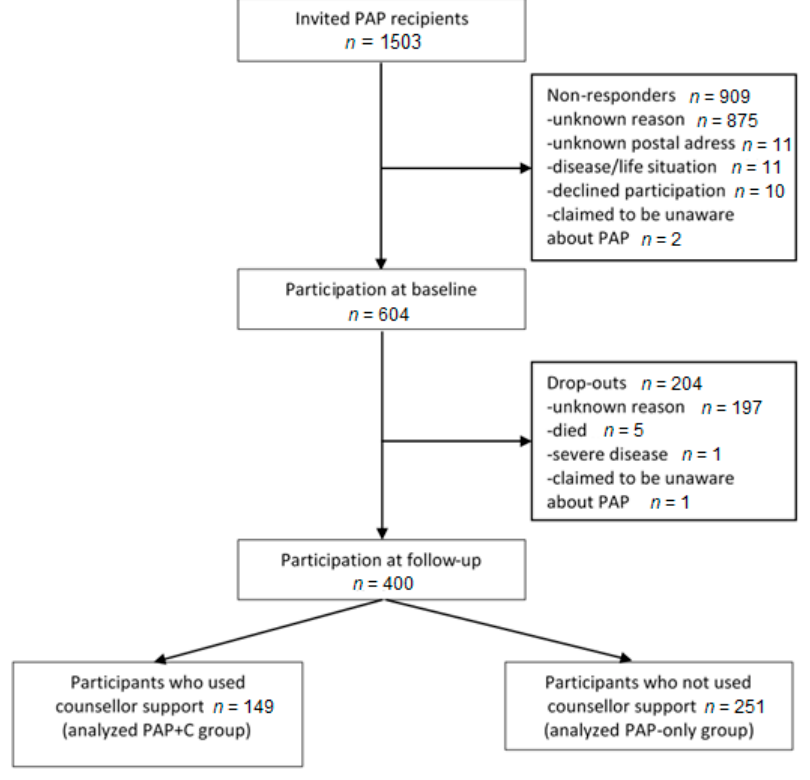
Figure 1. Flowchart of the recruitment process.